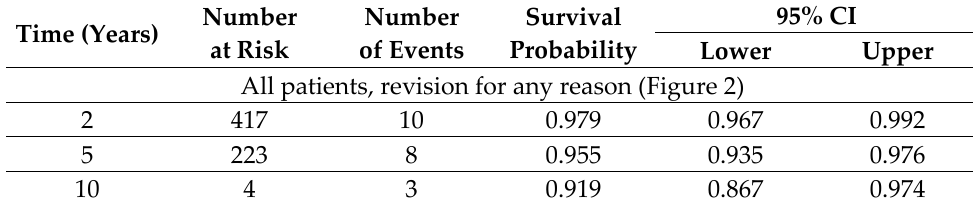
Figure 2. Kaplan–Meier survival analysis of all patients (512 lateral and medial unicondylar knee prostheses) over time (overall survival with revisions for any reason).